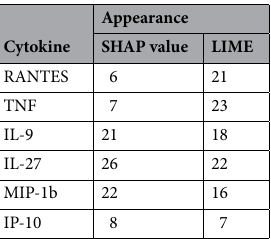
Table 6. The top selected feature in the case of Healthy for both explainers.